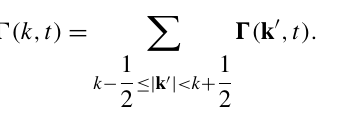
−√ (cid:104)√ ρ u / ρ (cid:105) vector field), and (b) its compensated